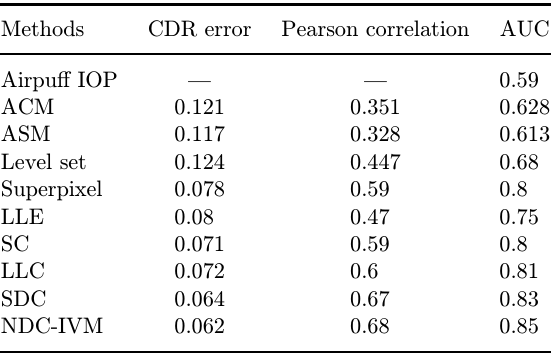
Table 2. Performance analysis for SiMES dataset.